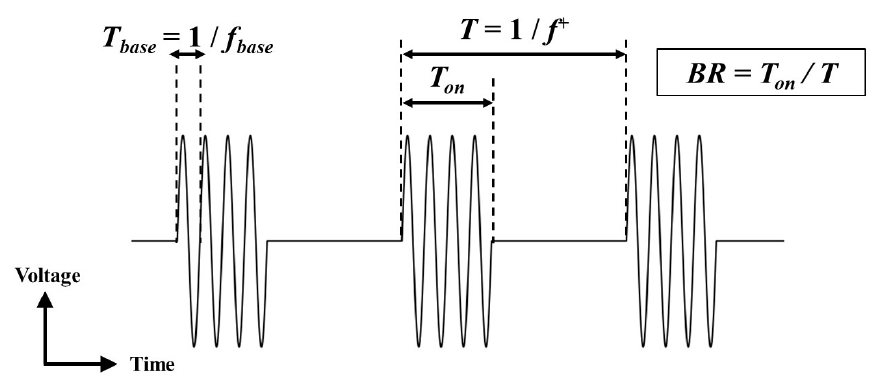
Figure 2. Schematic of the burst-mode driving. In this figure, the burst ratio ( BR ) was set to